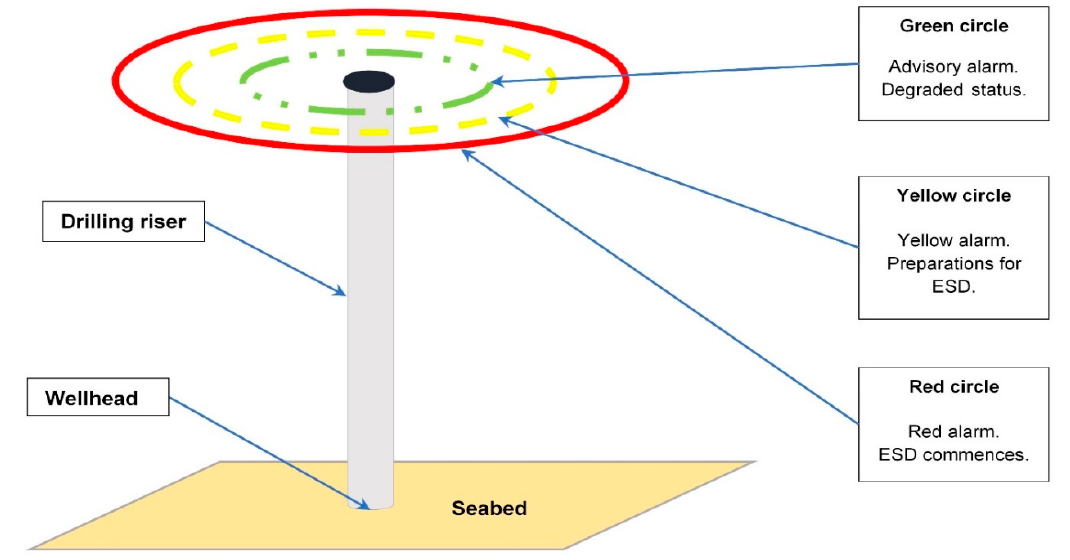
Figure 1. Dynamic positioning watch circle (the excursion limits are not to scale; ESD: emergency shutdown; created by the authors).